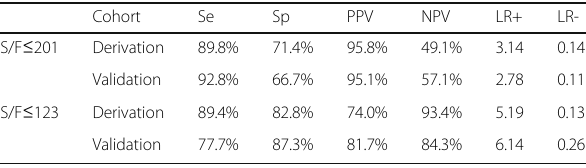
Table 1 (abstract 000583). See text for